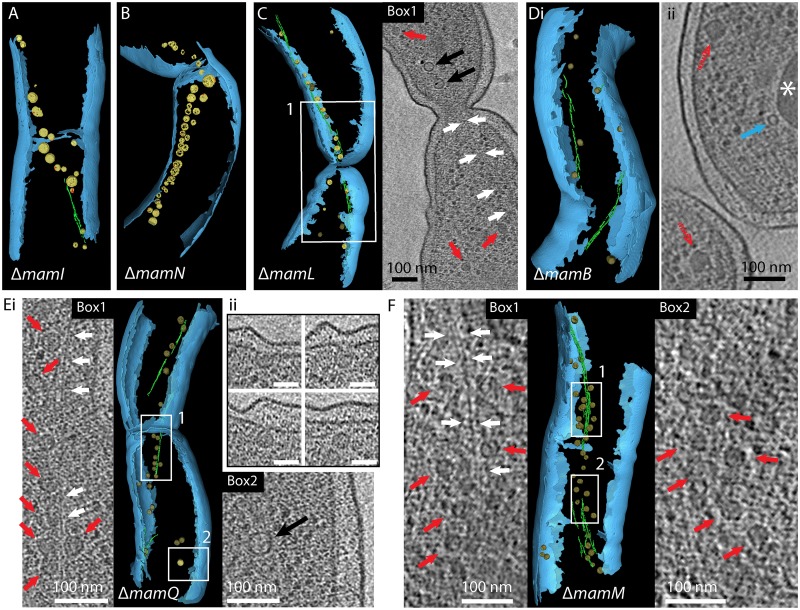
Cryo-electron tomograms of different MSR-1 mutant strains.Segmented tomograms show representative phenotypes of mutants (compare with S1 Table). The inner and outer membrane of the cells are depicted in blue, wild type-like magnetosome membranes (MMs) in yellow [black arrow in x-y slices], iron-minerals in red and the magnetosome filament in green [white arrow in x-y slices]. Distinguishable dense magnetosome membrane-like structures (DMMs) are depicted in dark yellow [red arrows in x-y slices], emphasizing the differential appearance in contrast to wild type-like MMs. Full tomograms are shown in S3–S8 Videos. (A): ΔmamI cell containing wild type-like MMs that partially enclose mineral particles. (B): ΔmamN cell containing a dense chain of empty and partially magnetite-filled wild type-like MMs. (C): ΔmamL cell with x-y slice detail (Box 1), showing small wild type-like MMs, partially containing crystals, and potential DMMs. (Di): ΔmamB cell displaying some putative isolated DMMs. (Dii): x-y slice detail of another tomogram shows putative DMMs (dashed red arrows) and a “mini-inclusion” structure (blue arrow) occasionally seen also in tomograms of the wild type and several other mutants. Asterisks marks polyhydroxyalkanoate inclusion that also occurred in all other analyzed strains. (Ei): ΔmamQ cell with two x-y slice details (Box 1 and Box 2). Box 1 shows filament-attached DMMs, Box 2 shows putative wild-type like MM. (Eii): x-y slice sections of another tomogram show four putative DMMs of which some appear continuous with the cytoplasmic membrane. Scale bars: 50 nm (F): ΔmamM cell with two x-y slice details (Box 1 and Box 2) showing filament attached DMMs.